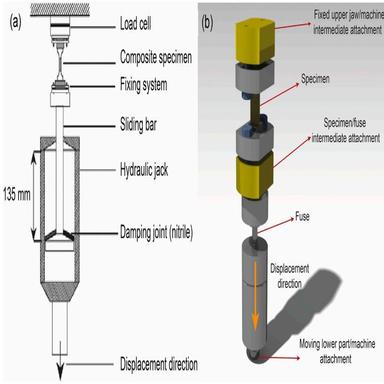
Schematics of (a) high strain-rate tensile test, (b) interrupted tensile device.